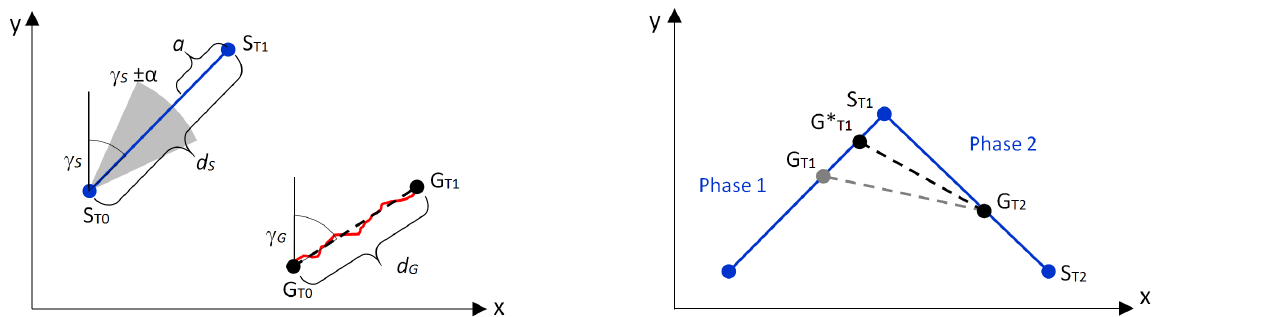
movements. On the screen, the stimulus moves from position S T 0 to S T 1 . The stimulus vector is defined by its angle g S and distance d S . The gaze vector is calcu- lated using the gaze positions G T 0 and G T 1 detected at the beginning and end of the stimulus movement, and defined by g G and d G , accordingly. These parame- ters are shown in Figure 4, a hypothetical gaze path is drawn in red colour, the corresponding gaze vector as a dashed line. By comparing stimulus and gaze vectors, the classification is performed independent of